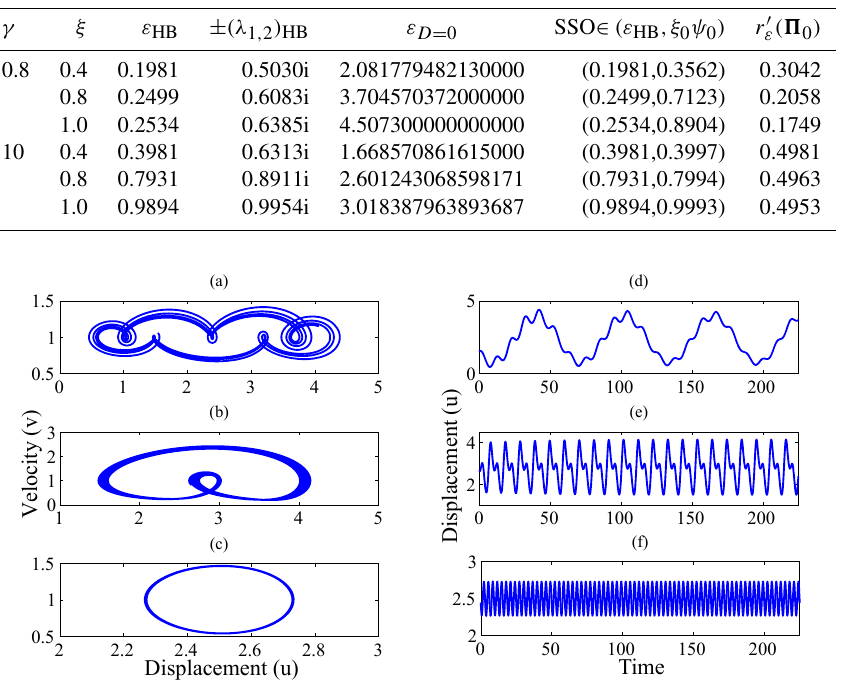
Figure 6. Projection of the attractor onto the plane (u,v) and time series of the perturbed system 5. Panels (a) , (b) , and (c) show the projection onto the plane for ω = 0 . 1 , 1 . 2, and 2, respectively. Panels (d) , (e) , and (f) display their respective time series for u